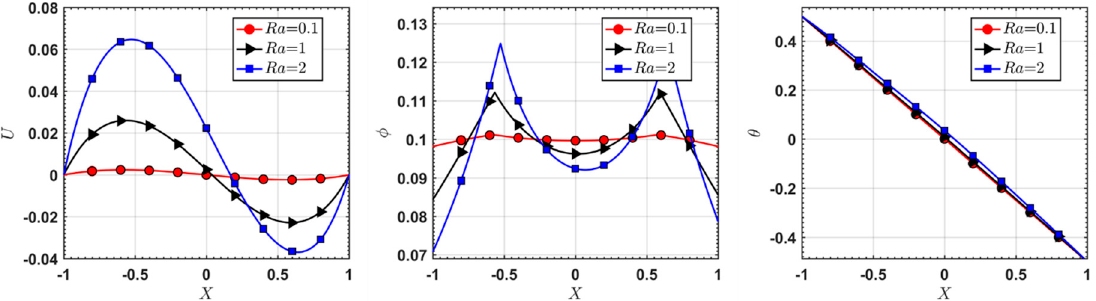
Figure 2. Effect of the buoyancy force term, the Rayleigh number ( 𝑅𝑎 ) on the velocity, concentration Figure 2. E ff ect of the buoyancy force term, the Rayleigh number ( Ra ) on the velocity, concentration and temperature profiles, when 𝛤 𝑐 = 2.5 , 𝛤 𝜇 = 0.1 , 𝐿𝑒 = 10 , 𝑛 = −0.5 , 𝛿 = 1 , 𝐵𝑟 = 5 and 𝜙 and temperature profiles, when Γ c = 2.5, Γ µ = 0.1, Le = 10, n = − 0.5, δ = 1, Br = 5 and φ avg = 0.1 .